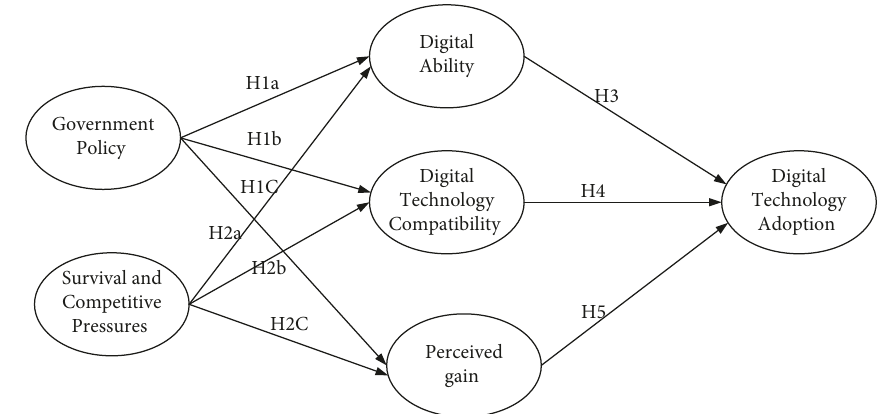
Figure 1: Research model and hypotheses.